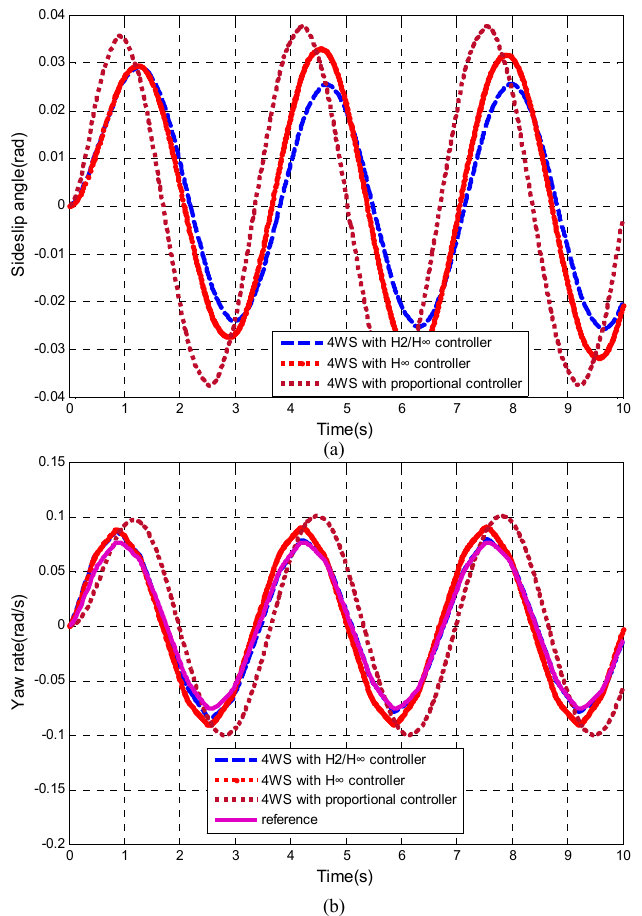
Figure 21. The sinusoidal responses of the front wheel angle: ( a ) sideslip angle response; ( b ) yaw rate response.